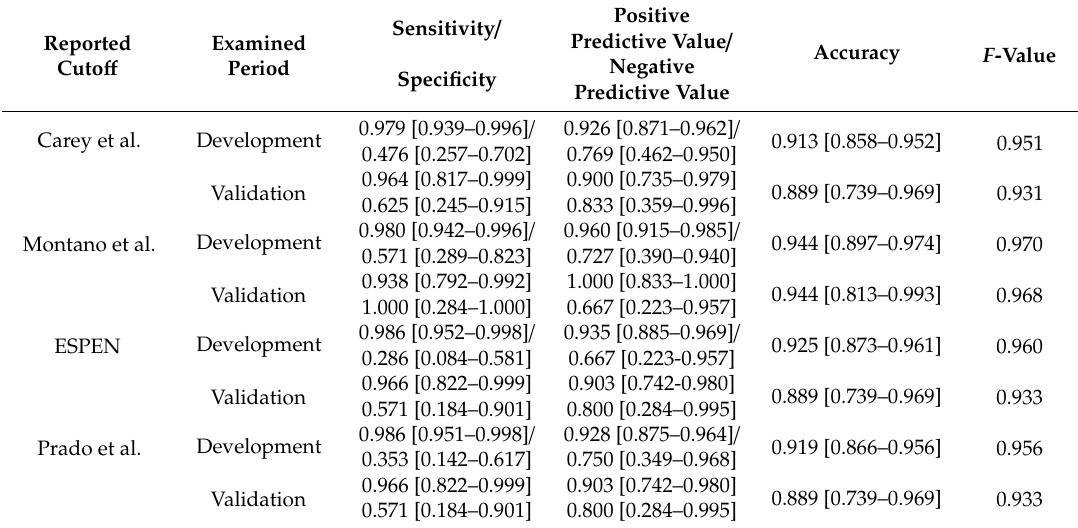
Table 3. Accuracy of the predicted SMI using several external